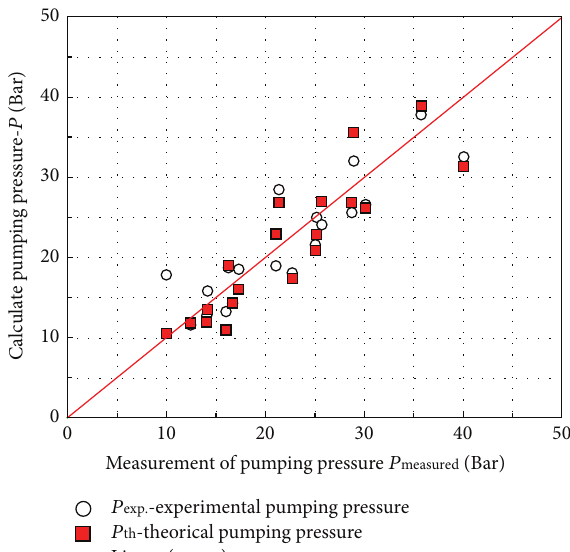
Model versus measurement (with superplasticizer) Model versus measurement (without superplasticizer) Figure 15: Validation of the model with the measurements.